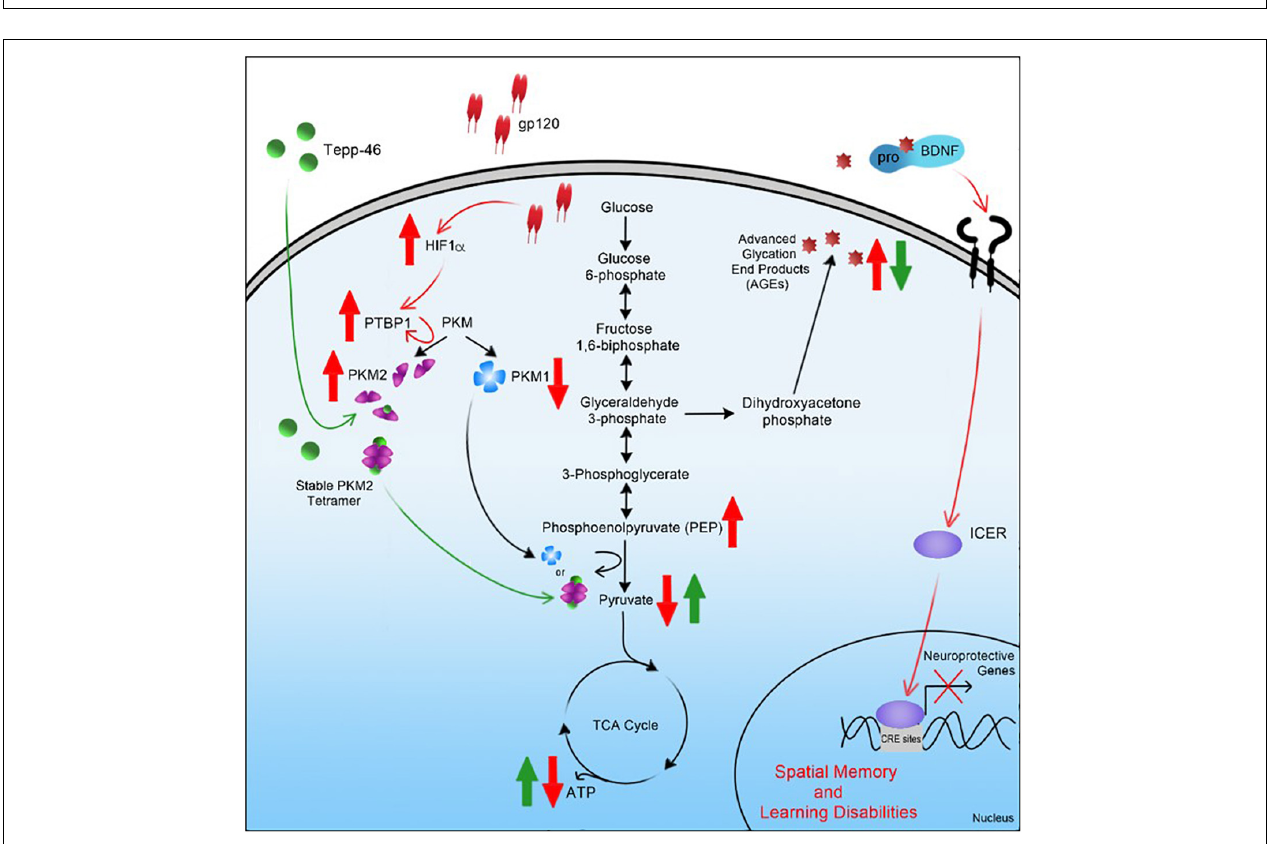
FIGURE 11 | Graphical summary of project. A schematic representation of the pathway used by HIV-1 gp120 is elucidated here leading to metabolic reprogramming in neurons and contributing to cellular changes associated with